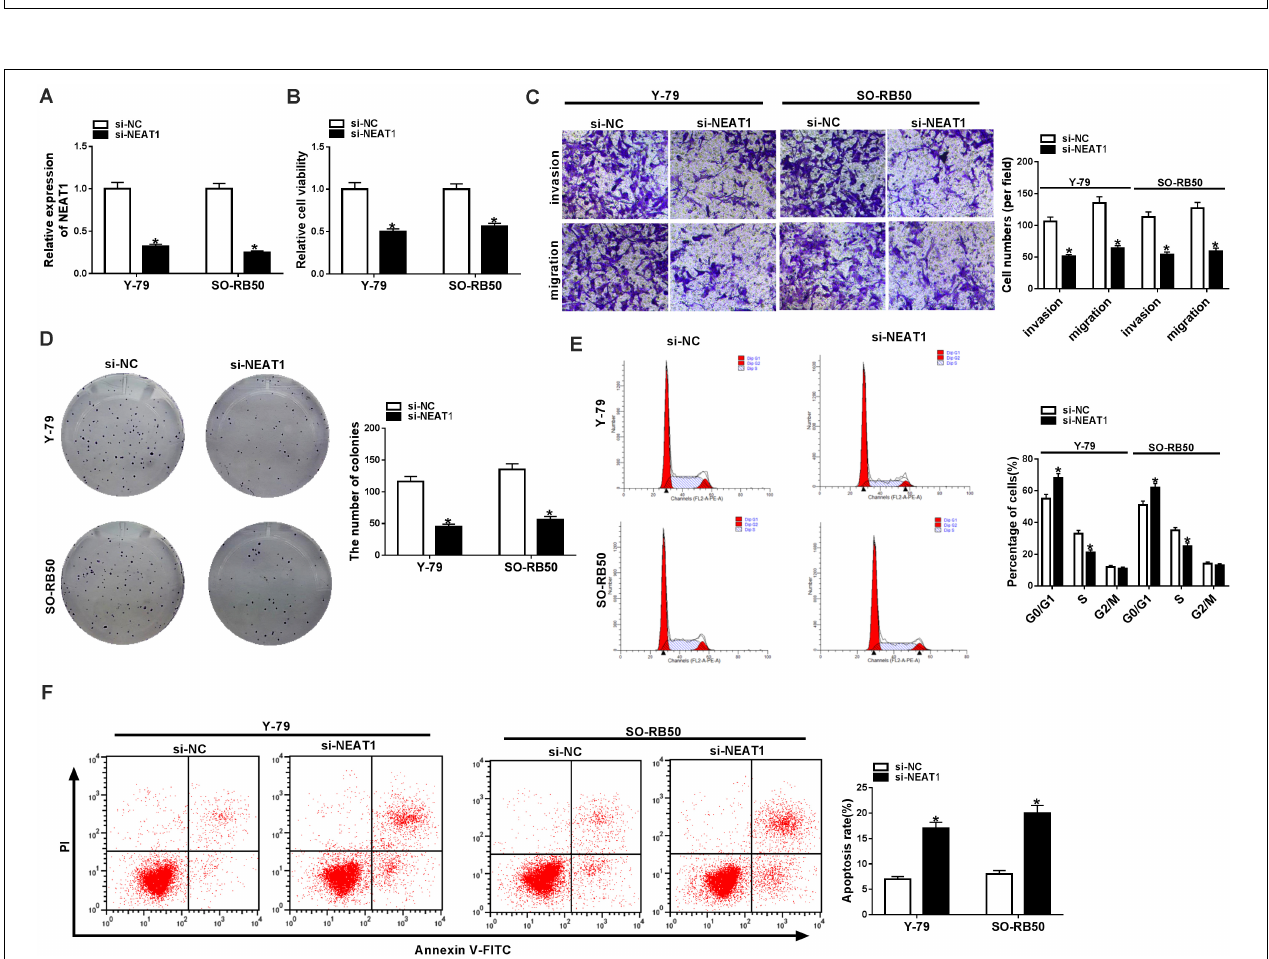
FIGURE 2 | NEAT1 silencing repressed the progression of Y-79 and SO-RB50 cells. (A) The knockdown efficiency of si- NEAT1 in Y-79 and SO-RB50 cells was determined by qRT-PCR. (B) The effect of NEAT1 knockdown on Y-79 and SO-RB50 cell viability was detected by CCK-8 assay. (C) The effects of NEAT1 silencing on the invasive and migratory abilities of Y-79 and SO-RB50 cells were detected by transwell assay. (D) Cell colony formation assay showed that the colony-forming ability of Y-79 and SO-RB50 cells was repressed by NEAT1 knockdown. (E) Flow cytometry analysis showed that cell cycle was arrested in G0/G1 phase by NEAT1 silencing in Y-79 and SO-RB50 cells. (F) Flow cytometry assay showed that NEAT1 knockdown induced RB cell apoptosis in Y-79 and SO-RB50 cells. * P < 0.05.